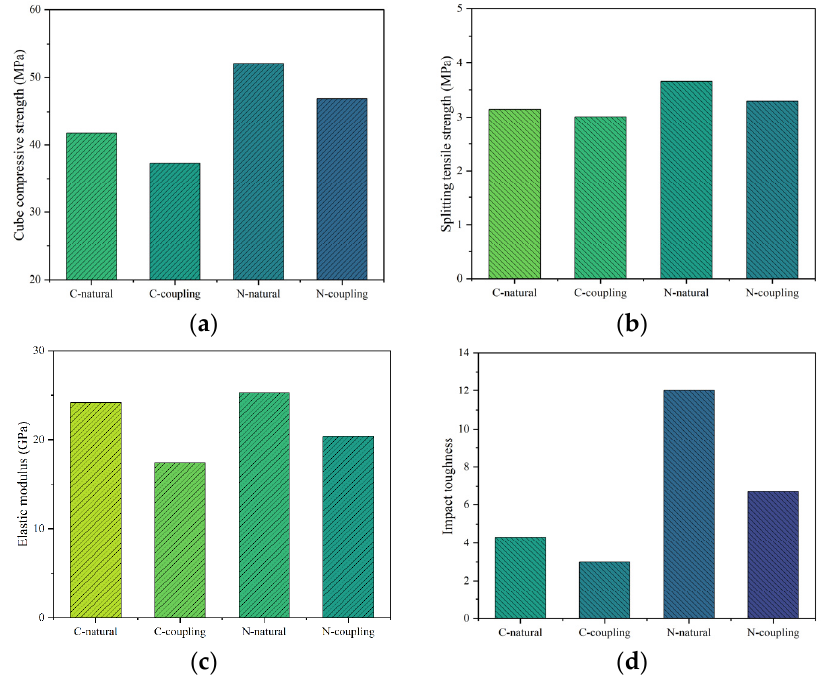
Figure 15. The mechanical properties of GPC under different environments. ( a ) Cube compressive strength; ( b ) Splitting tensile strength; ( c ) Elastic modulus; ( d ) Impact